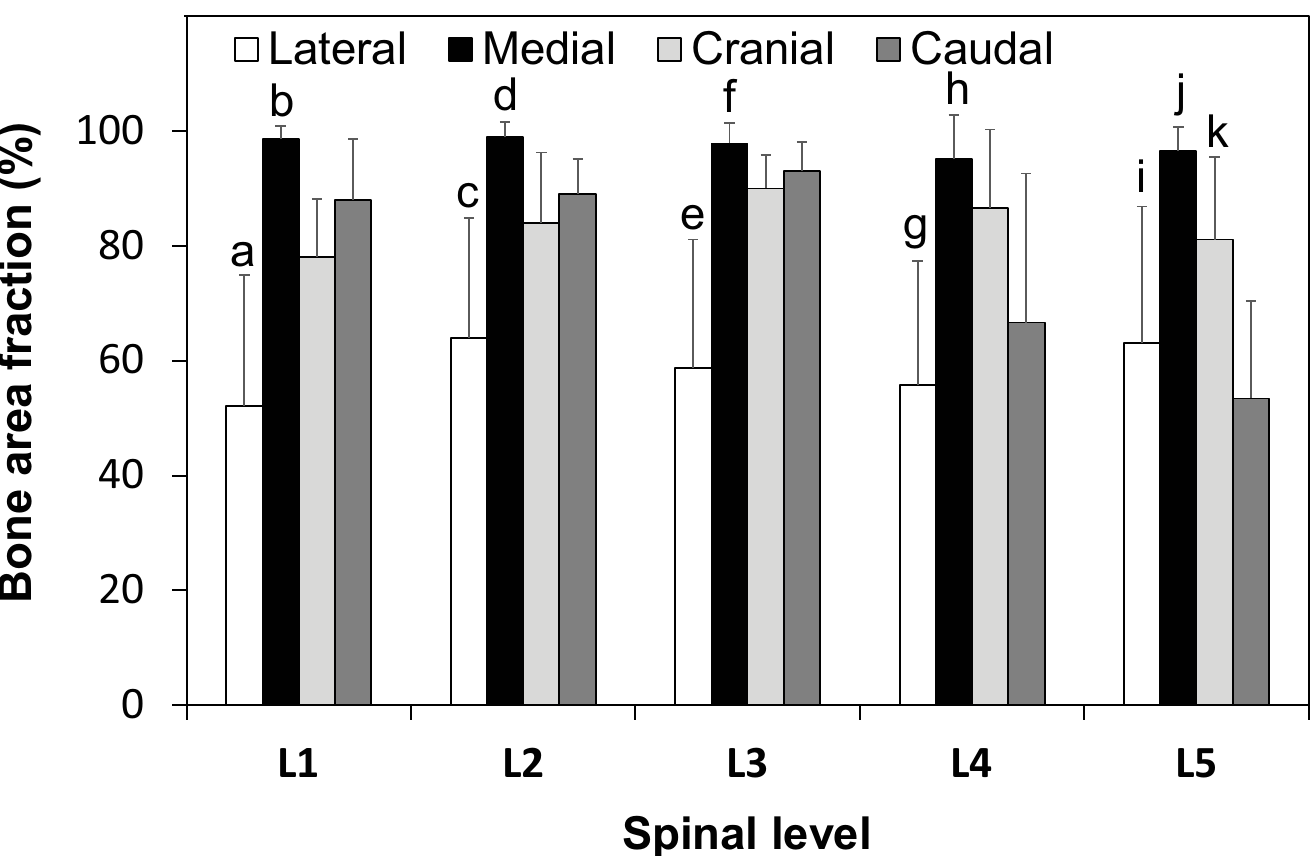
Fig 3. Regional and level comparison of bone area fraction. (mean ± SD). a : compared with medial (p < 0.0001), cranial (p < 0.02) and caudal (p < 0.002) in L1. b : compared with cranial (p < 0.0001) and caudal (p < 0.03) in L1. c : compared with medial (p < 0.0009), cranial (p < 0.03) and caudal (p < 0.02) in L2. d : compared with cranial (p < 0.02) and caudal (p < 0.0004) in L2. e : compared with medial (p < 0.0004), cranial (p < 0.002) and caudal (p < 0.0006) in L3. f : compared with cranial (p < 0.01) and caudal (p < 0.02) in L3. g : compared with medial (p < 0.0004) and cranial (p < 0.002) in L4. h : p < 0.03 compared caudal in L4. i : compared with medial (p < 0.002) and cranial (p < 0.05) in L5. j: compared with cranial (p < 0.02) and caudal (p < 0.0001) in L5. k : compared with caudal (p < 0.0006) in